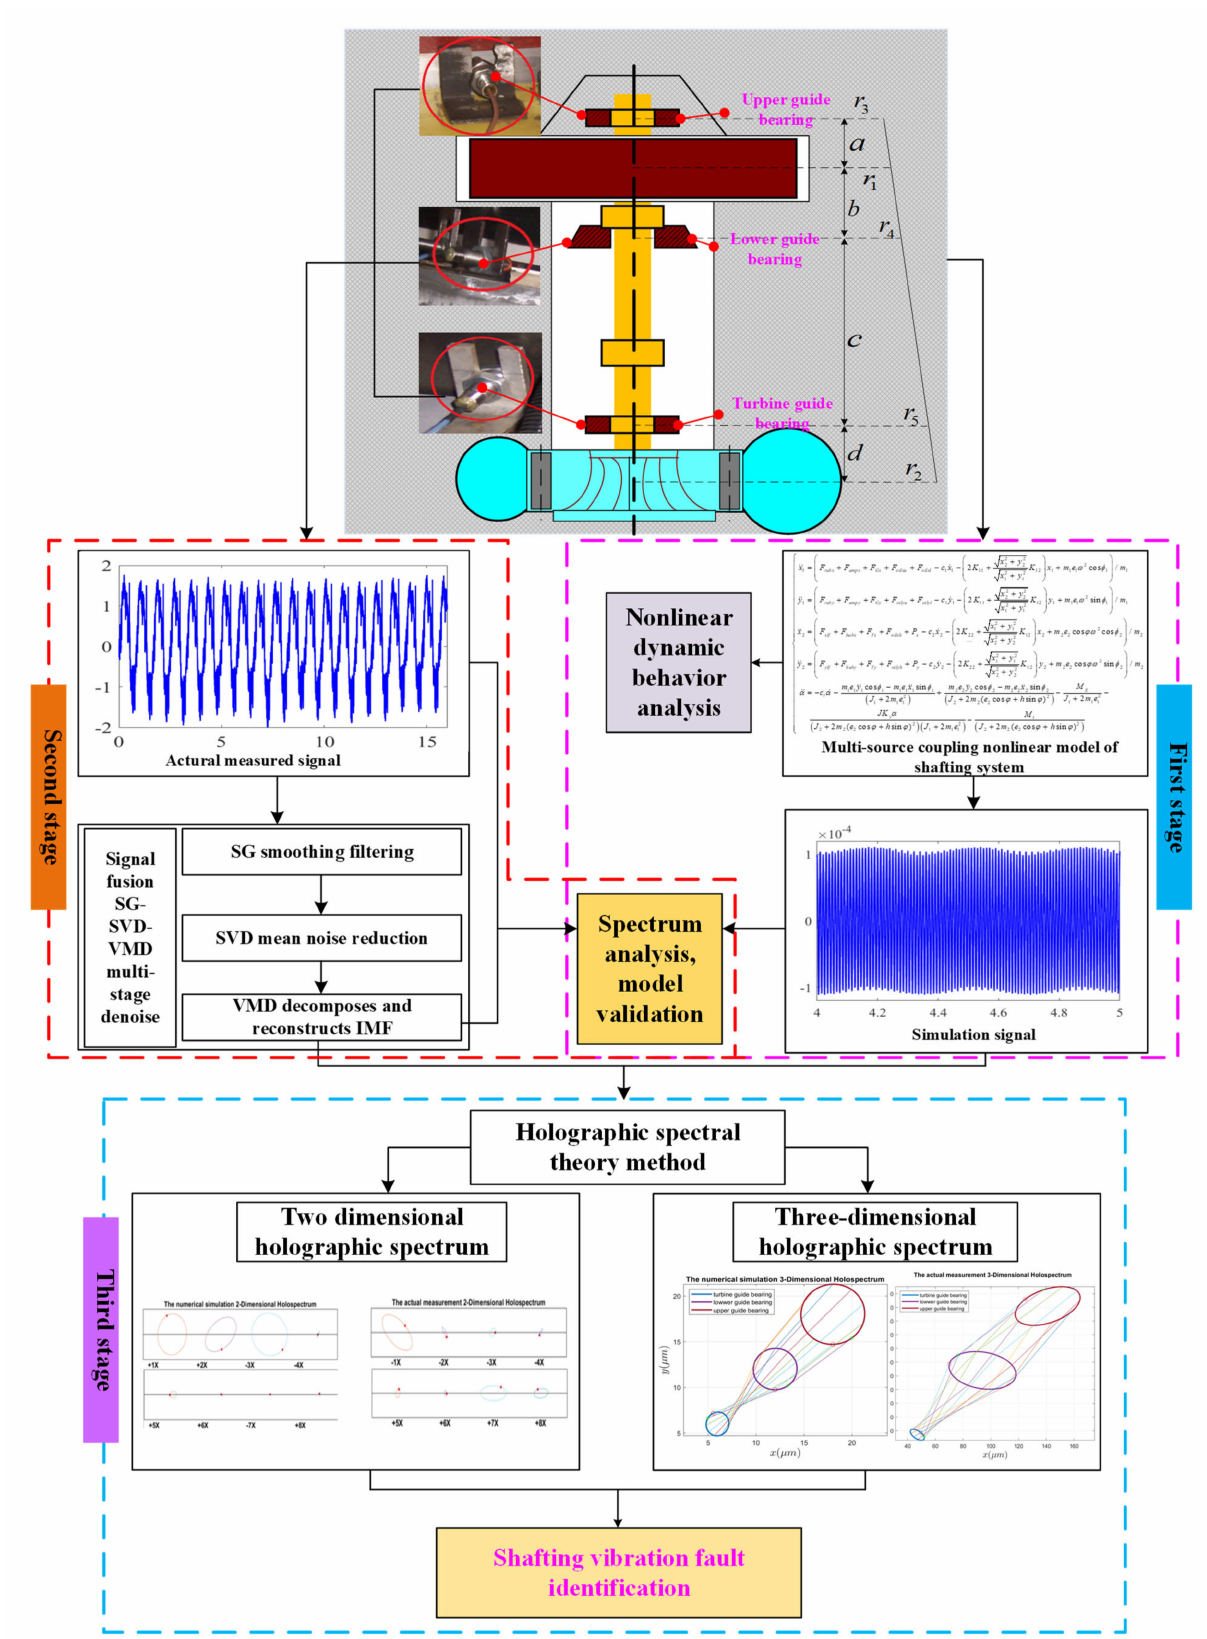
Figure 1. Shafting system vibration fault identification